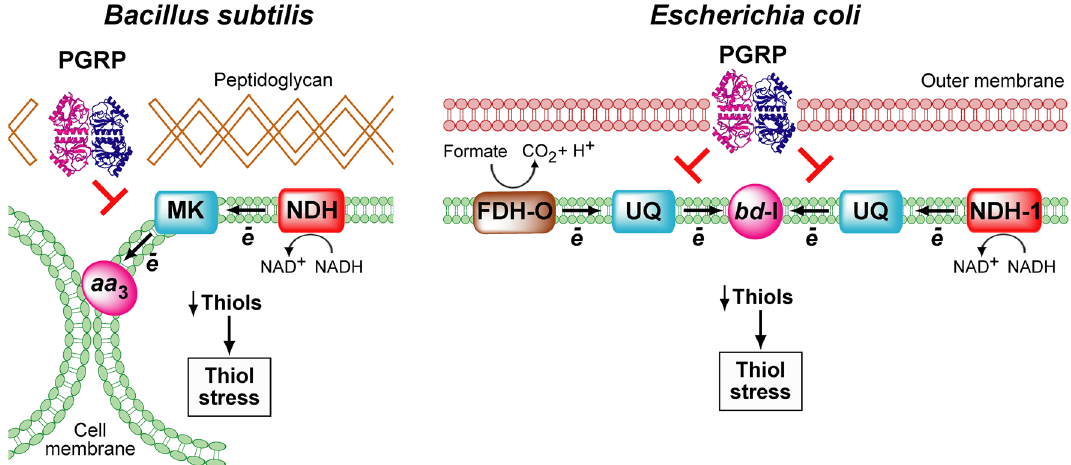
Figure 11. Proposed events in PGRP-induced thiol stress in B. subtilis and E. coli . PGRP binds to peptidoglycan in the cell separation site in dividing B. subtilis or to the outer membrane in E. coli 9 and interferes with the function of the respiratory electron transport chain, consisting of NDH, MK (and DMK), and cytochrome aa 3 - 600 in B. subtilis , or FDH-O, NDH-1, UQ, and cytochrome bd- I in E. coli 11,26 , leading to depletion (oxidation) of cellular thiols and thiol